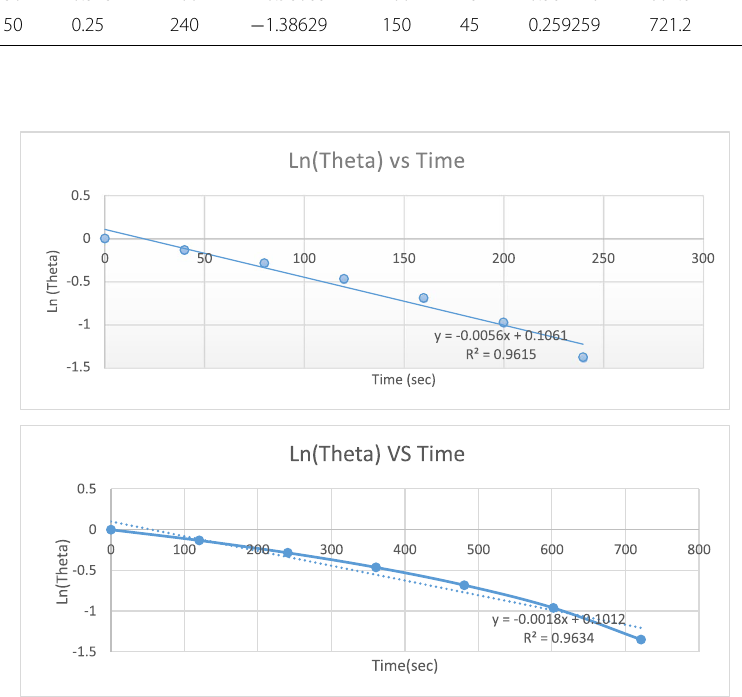
Fig. 8 Ln(theta) temperature time at 150 °C D